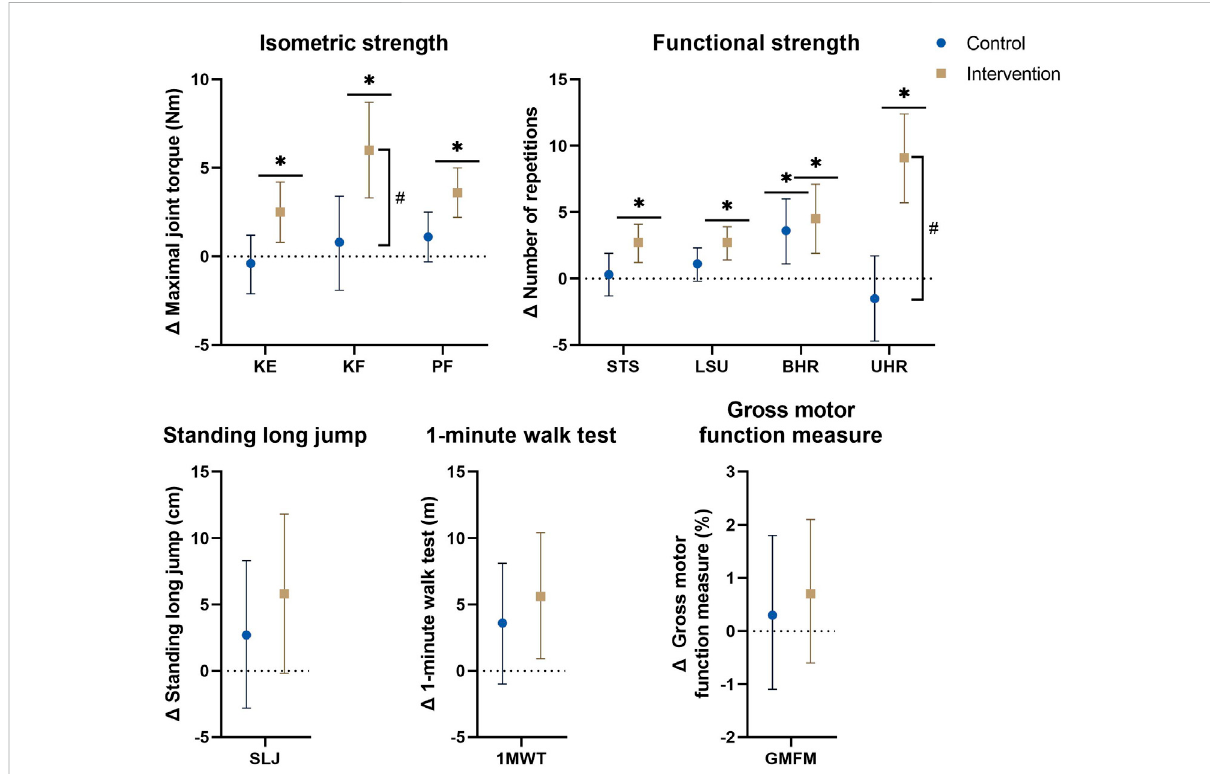
FIGURE 3 Estimatedmarginalmeandifferenceswith95%con fi denceintervalofmixedmodelanalysesforstrengthandfunctionalparameterswithresults forwithinandbetweenanalysesincludingallparticipantsandallaffectedlegsforbilaterallytestedparameters.#:signi fi canttime*groupinteraction- effect at p ≤ 0.01. *: signi fi cant time-effect at p ≤ 0.01. Abbreviations: Δ , hange; 1MWT, 1-minute walk test; BHR, bilateral heel raise; GMFM, gross motor function measure; KE, knee extension; KF, knee fl exion; LSU, lateral step-up; PF, plantar fl exion; SLJ, standing long jump; STS, sit-to- stand; UHR, unilateral heel raise. Units: Cm, centimeter; M, meter; Nm, Newton-meter.